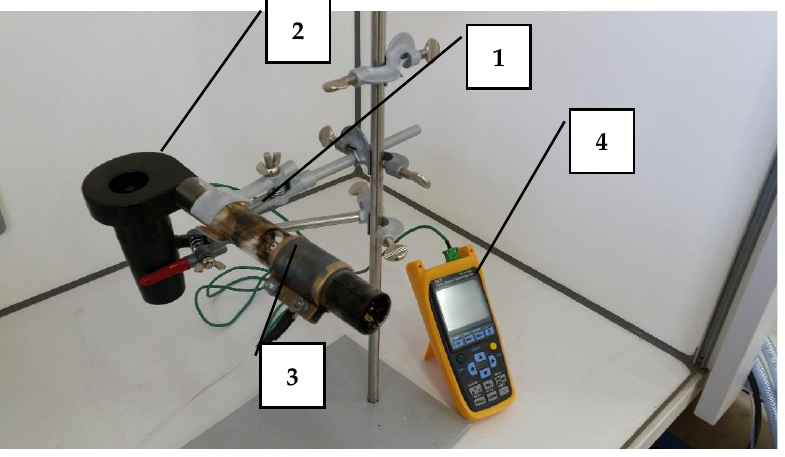
Figure 2. Stand for burning biomass particles.